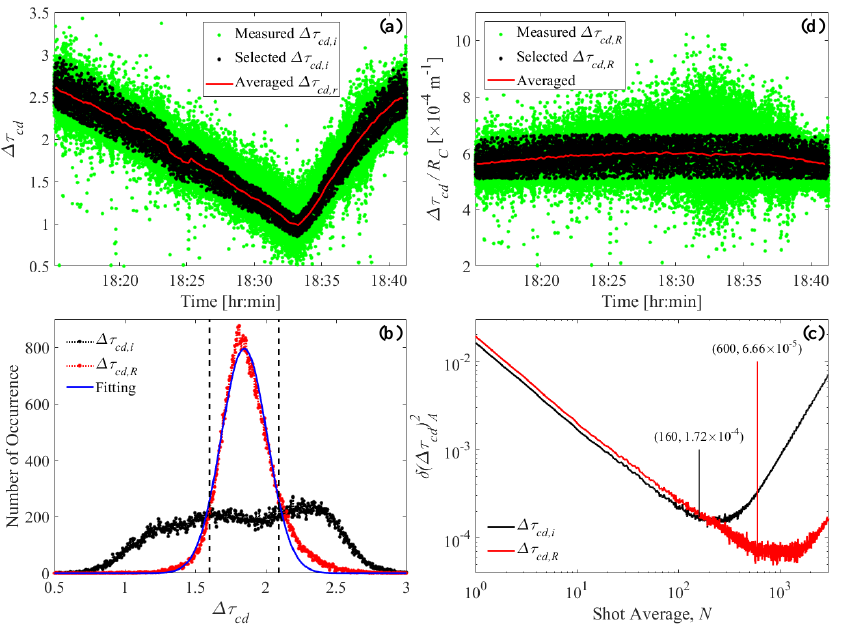
Figure 17. Summary of the airborne pulsed 2- µ m IPDA lidar statistical analysis of ∆ τ cd measurement. ( a ) Single-shot IPDA ∆ τ cd,i measurements, selected shots and 500 shot average. ( b ) Statistical distribution of ∆ τ cd,i and range-normalized ∆ τ cd,R with normal distribution fitting. Vertical dashed lines mark ± 1.5 standard deviation for the fitting. ( c ) Allan-variance analysis for ∆ τ cd,i and range- normalized ∆ τ cd,R . ( d ) range-normalized single-shot ∆ τ cd,R , selected shots and 500 shot average.